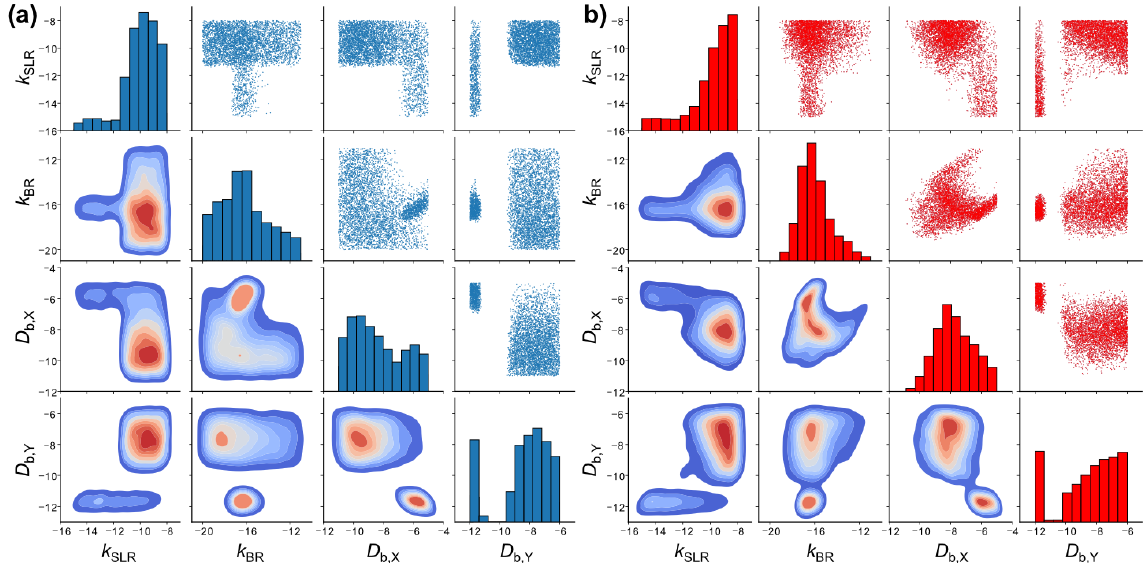
Figure 7. Scatter plot matrices of the fitting parameter space of 5000 fits to six experimental datasets of the ozonolysis of oleic acid aerosols (Appendix B) obtained with (a) KM-SUB and (b) the NN surrogate model. Shown are four out of seven optimized kinetic parameters. The diagonal elements are histograms showing the distributions of the individual fit parameter densities. The off-diagonal elements are scatter plots (top right) or densities (bottom left) of solutions for all possible combinations of two kinetic parameters. The KM-SUB fit ensemble originates from the application of the MHA with a step size of 0.1 and the NN fit ensemble from log-uniform random